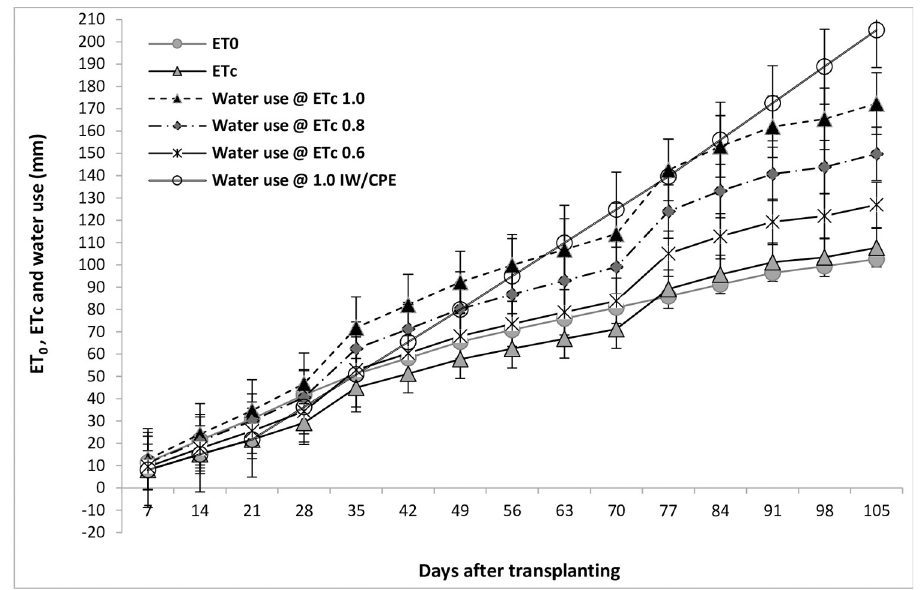
Fig 2. Weekly sum of reference evapotranspiration (ET 0 ), crop evapotranspiration (ETc) and crop water use at different irrigation schedules during the cropping period (average weekly data of